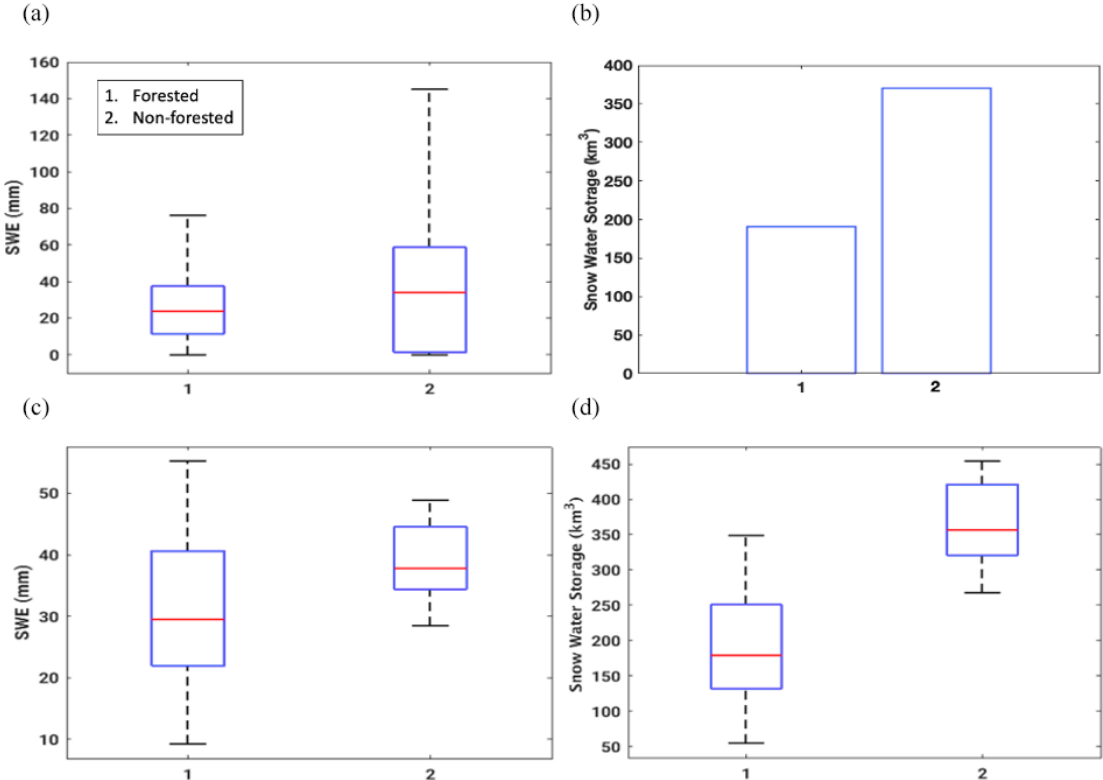
Figure 10. Same as Fig. 7 but for forested areas vs. non-forested